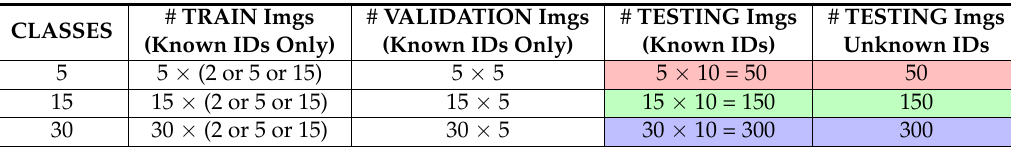
Table 1. Performances in face recognition are evaluated for different classifiers trained with a different amount of outputs (classes). This table summarize the number of samples used in each case. A limited number of individuals (5, 15 or 30) is extracted from the dataset: these are the identities we want to recognize. During the training (and the validation), only known IDs samples are provided. Note that the desired number of training samples (2, 5 or 15) is kept constant for each class. This choice allows for a perfect balance between each class, giving no a priori information through sample distribution. During the testing, all the other identities outside of the closed set of known IDs can potentially provide unknown samples. The classifier is tested against the unknown IDs rejection providing a fixed number of images that is equal between the known and unknown individuals. Again, no predilection on a particular class or on the “unknown” is